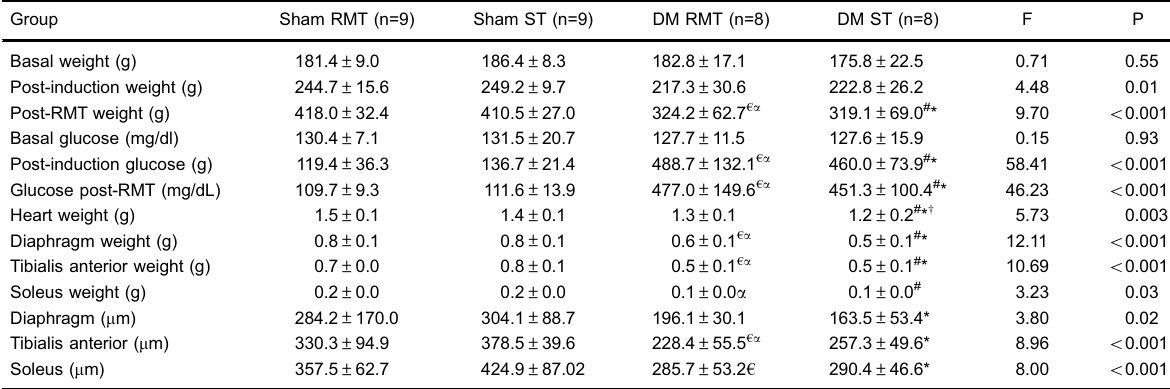
Table 1. Measurement of weight, blood glucose, and muscle fi bers between groups of rats with streptozotocin-induced diabetes mellitus (DM), sedentary (ST) or treated with respiratory muscle training (RMT), and controls (Sham).